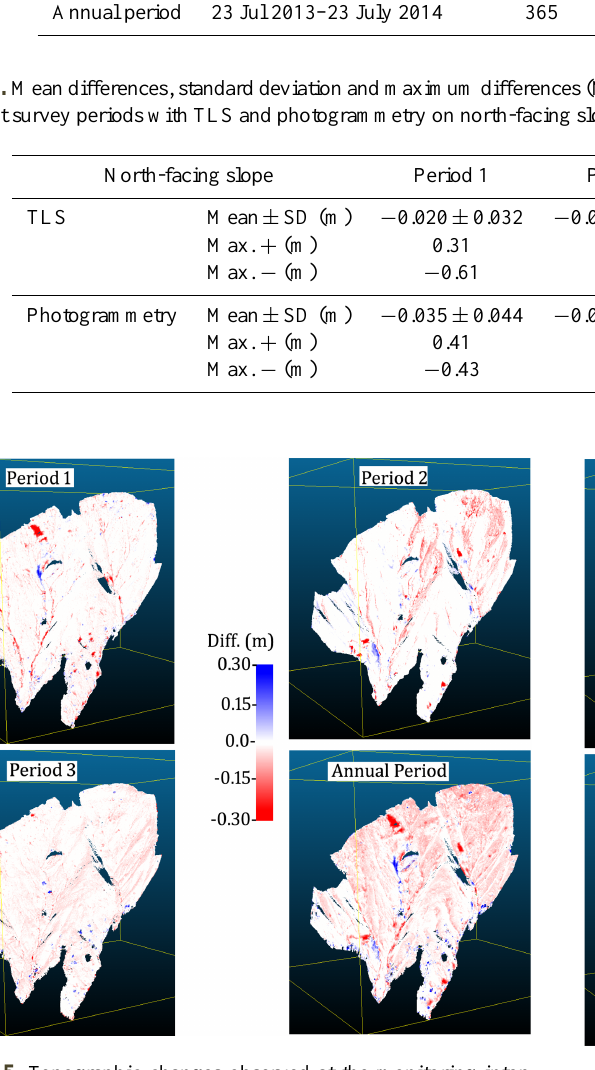
Figure 5. Topographic changes observed at the monitoring inter- vals and at annual scale obtained with TLS on north-facing slopes (CloudCompare software).